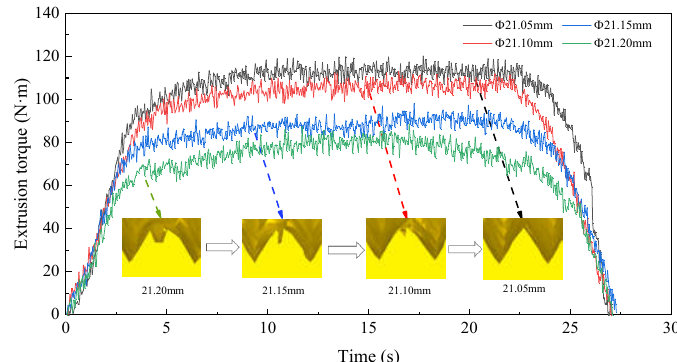
Figure 17. Influence of bottom hole diameter on torque.